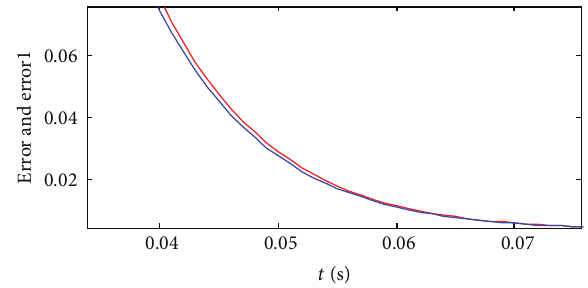
Figure 5: Tracking curve of PID controller based on memristive CMAC.